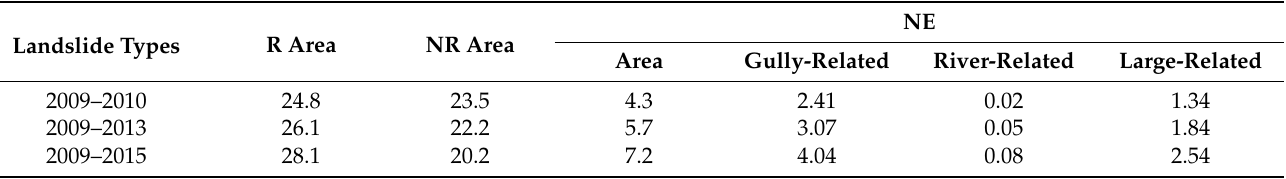
Table 7. Statistical data of landslide evolution from 2009 to 2010, 2013, and 2015 in the ARW . NE Landslide Types R Area NR Area Area Gully-Related River-Related